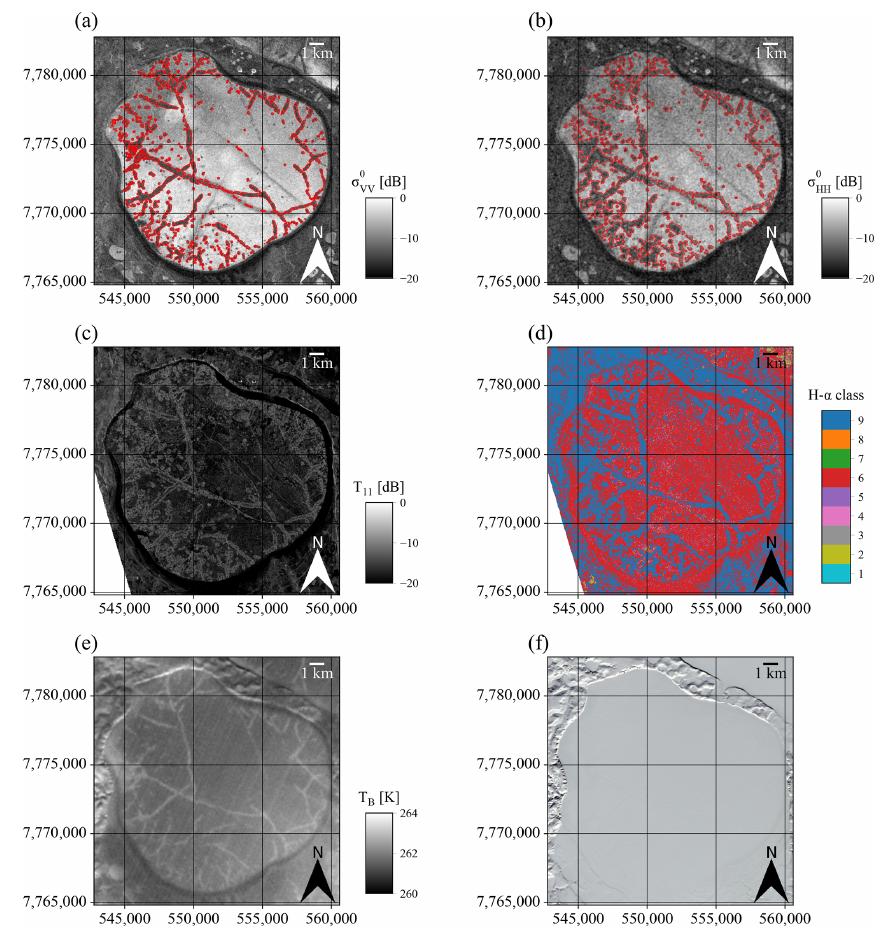
Figure 11. Comparison of Sentinel-1 C-band data, ALOS PALSAR-2 L-band polarimetric results, and Landsat 8 brightness temperature and surface reflectance for Lake Neyto in April 2015. (a) Sentinel-1 IW VV-polarised acquisition from 10 April 2015. (b) Sentinel-1 EW HH- polarised acquisition from 23 April 2015. (c) ALOS PALSAR-2 T 11 from 18 April 2015. (d) Polarimetric classification result from ALOS PALSAR-2 scene acquired on 18 April 2015 (pixel values denote zones in the H - α plane; zone 6 is termed “random surface” and zone 9 is termed “Bragg surface” in Lee and Pottier, 2009). (e) Landsat 8 band-10 brightness temperature from 6 April 2015. (f) Landsat 8 true-colour composite of surface reflectance data from 6 April 2015. Outlines of classified backscatter anomalies are shown in red in (a) and (b) . CRS: WGS 84 / UTM zone